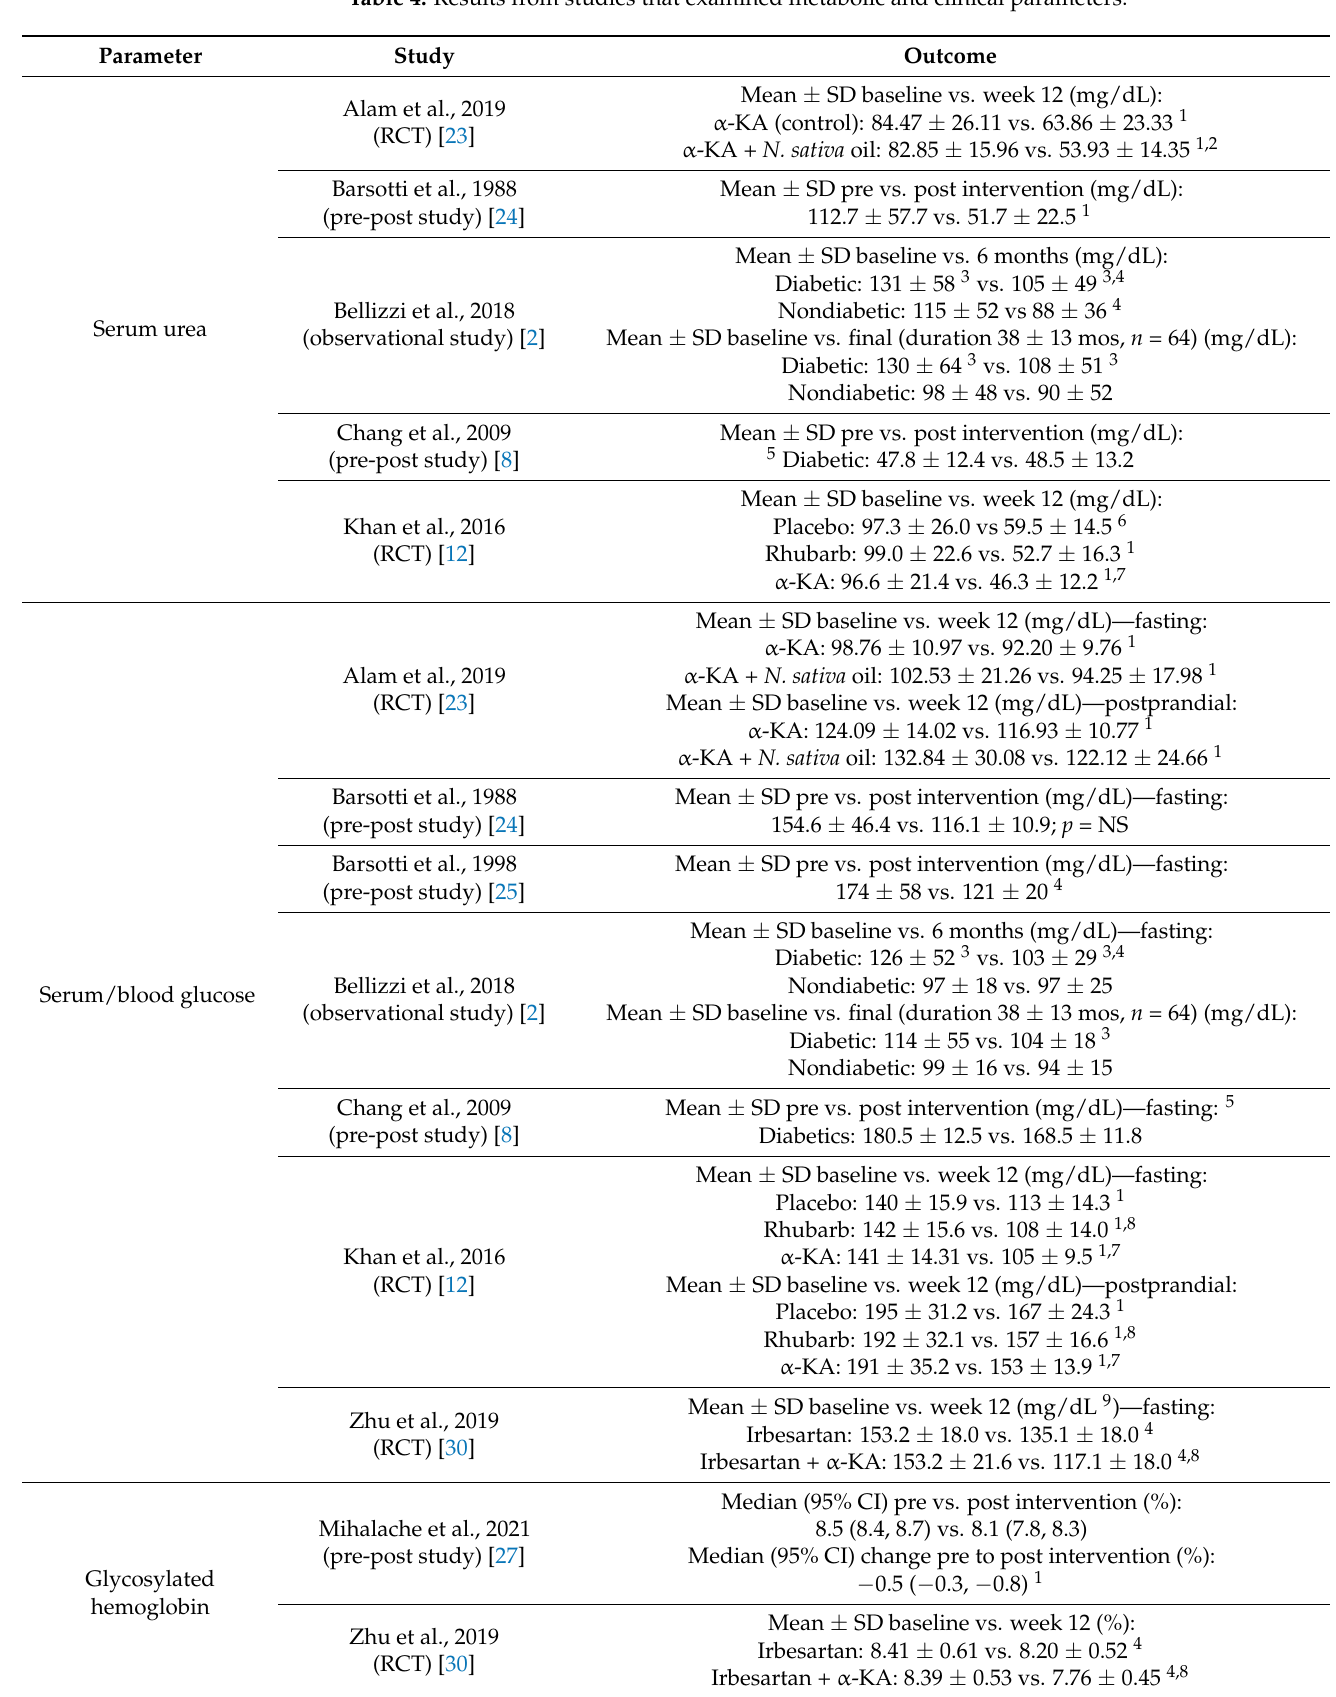
Table 4. Results from studies that examined metabolic and clinical